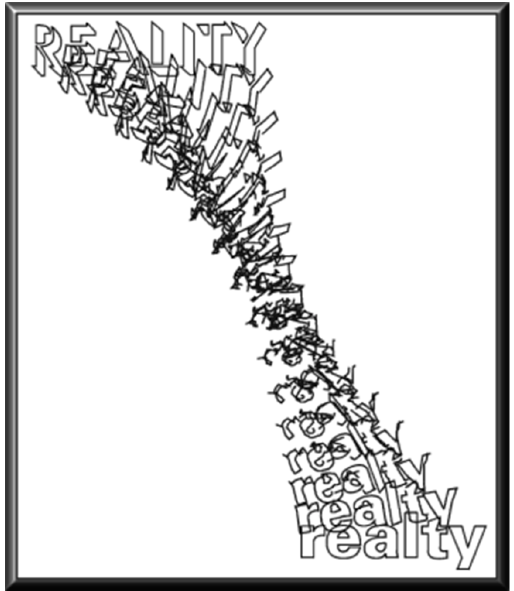
Figure 6. Jim Andrews, “Snapshot in the Continuing Adventures of I” 1990.